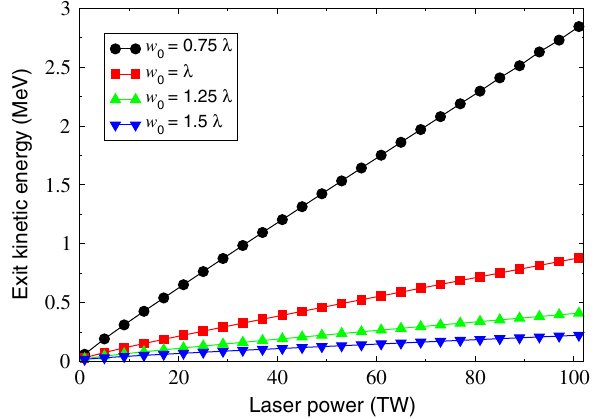
FIG. 6. Single (cid:2) -particle exit kinetic energies with increasing laser power, using the following parameters: ’ ¼ 15 (cid:1) , (cid:3) ¼ ¼ 2 (cid:4) (cid:3) 10 4 . 10 : 6 (cid:1) m , and (cid:10) f